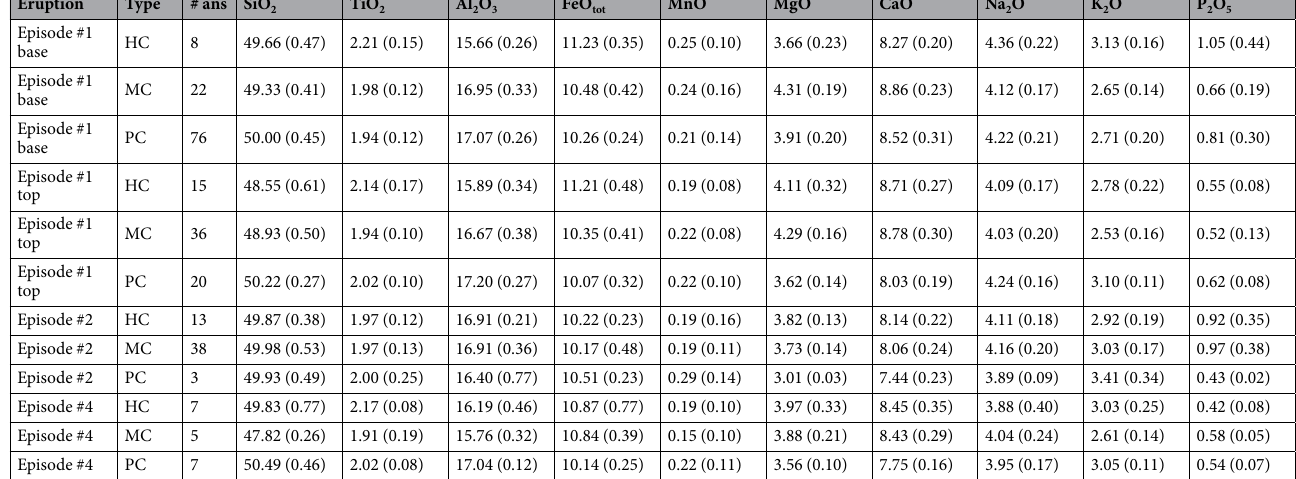
Table 2. Average composition of groundmass glass for the different textural types. HC = highly crystalline, MC = moderately crystalline; PC = poorly crystalline. # ans: number of analyses averaged. Standard deviation (1 σ ) from the mean is reported in brackets.